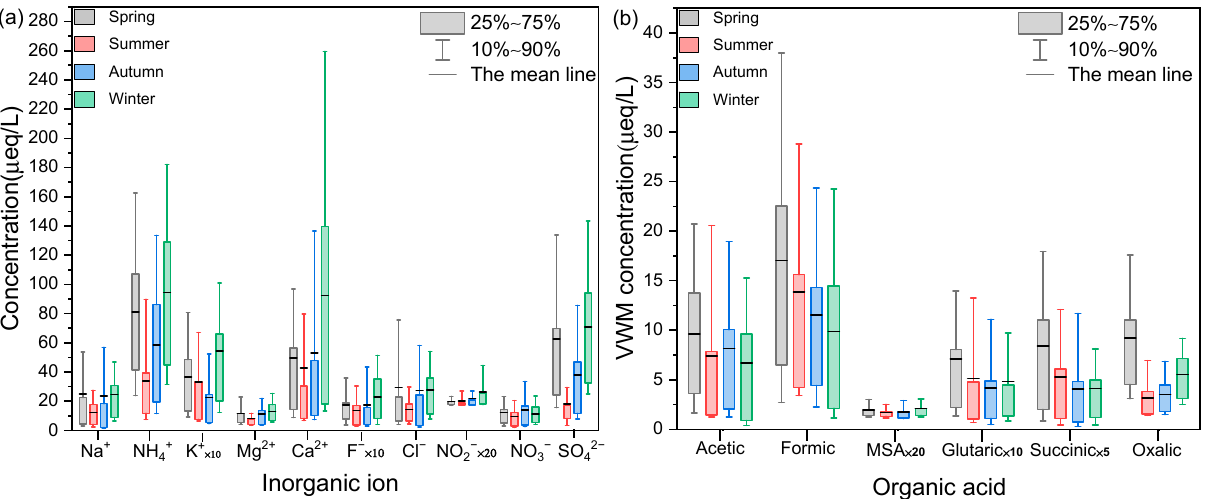
Figure 4. Seasonal variations of ( a ) water-soluble inorganic ions and ( b ) organic acids in rainfall events.